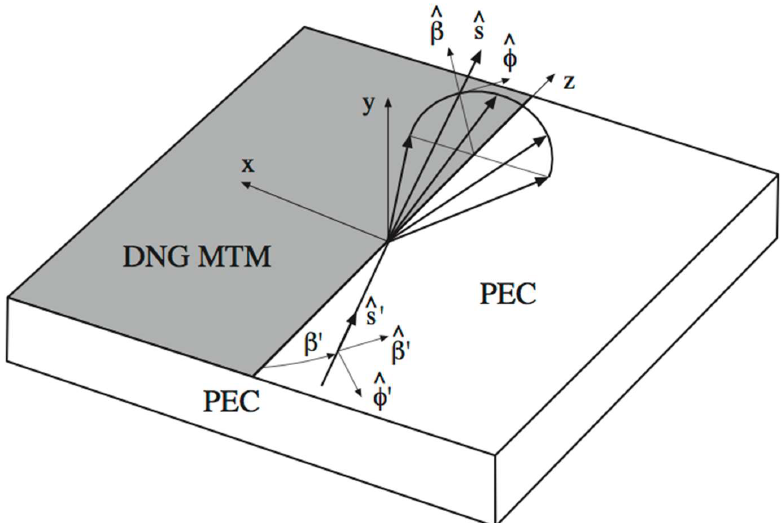
Figure 1. Useful reference systems for the scattering problem.